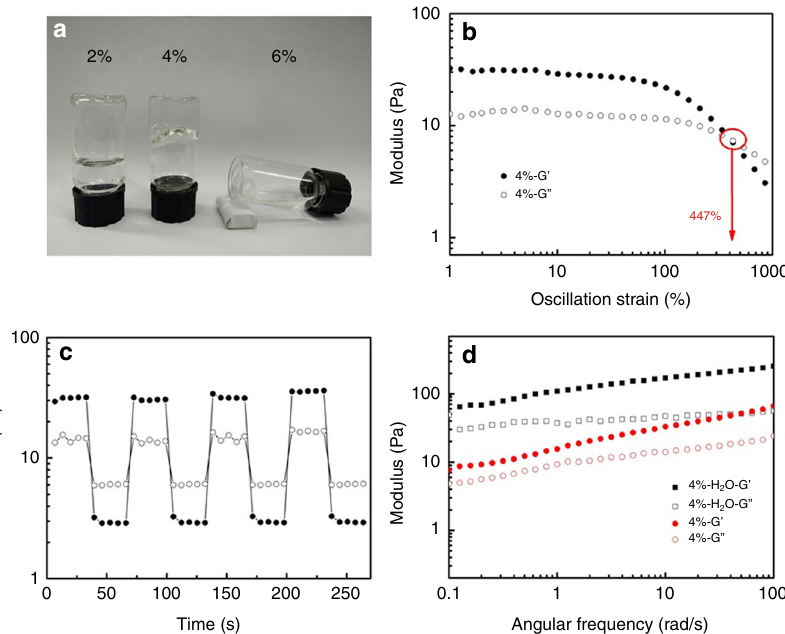
Fig. 2 Preparation and rheological characterization of PAAS solutions. a Photograph of PAAS solutions with different concentrations (2%: viscous liquid; 4%: physical gel; 6%: precipitate and liquid) in H 2 O:DMSO = 4:1 mixture at room temperature. b Strain-dependent and c step-strain oscillatory rheology of the optimal PAAS solution. The applied oscillatory strain in c alternated between 1 and 1000% for 30 s periods ( ω = 10 rads − 1 , 25 °C). d Frequency- dependent oscillatory rheology of 4% PAAS solution with pure water (black) or H 2 O: DMSO = 4:1 (red) as effect of NaCl was observed by using rheological measurements (Supplementary Fig. 14): the gel to sol cross-over point was increased from 447% to 680% strain simply by adding 50 mM NaCl into the optimal PAAS solution, which indicates the enhanced polymer – polymer interactions by addition of NaCl into solution 37 .